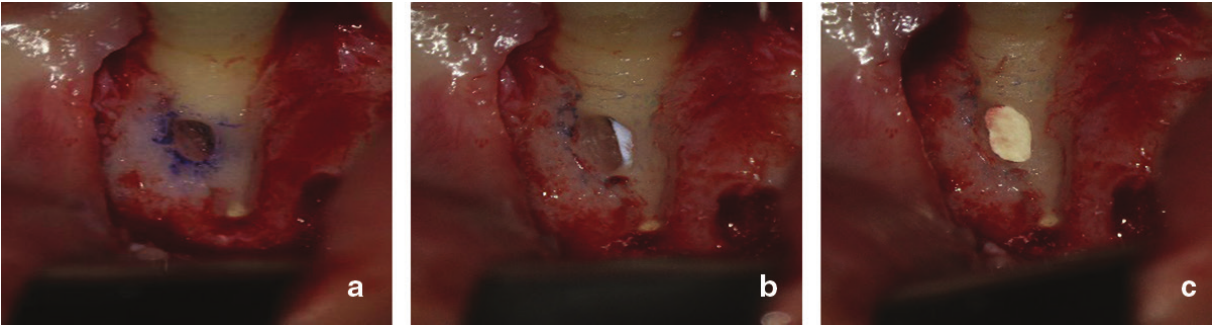
Fig. 6. (a) The lateral lesion of tooth 11 was detected; (b) the lateral lesion was removed and checked; (c) MTA repaired the lateral